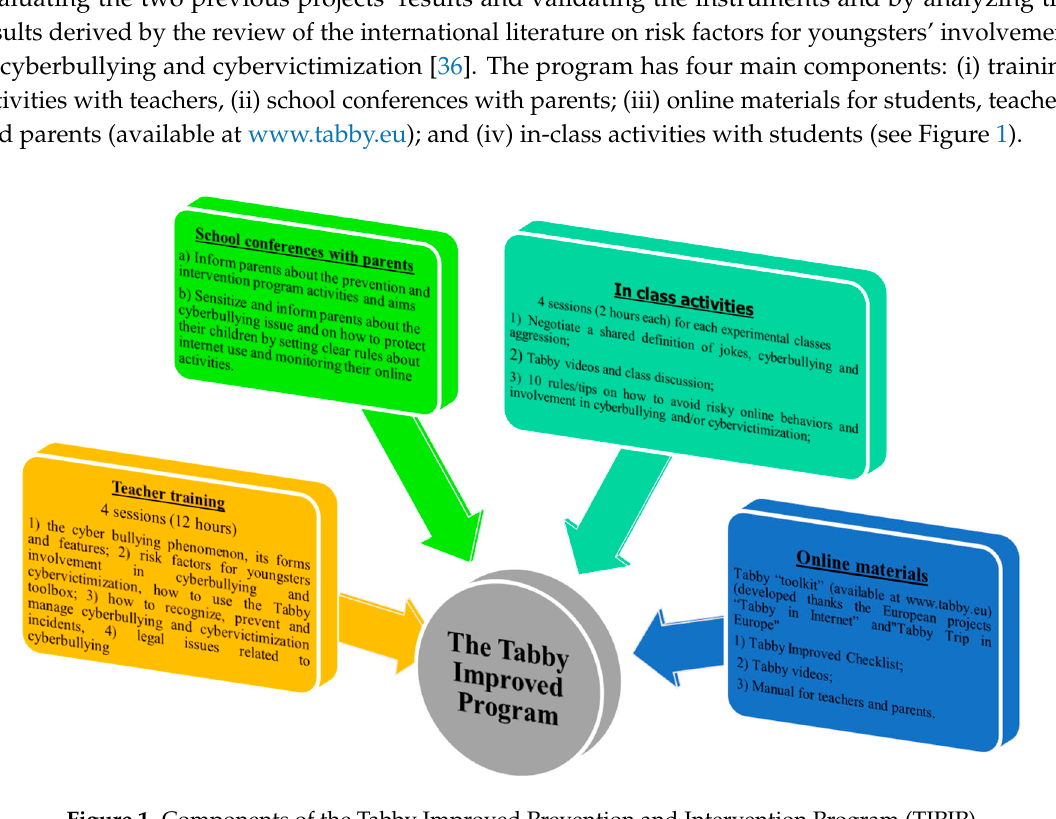
Figure 1. Components of the Tabby Improved Prevention and Intervention Program (TIPIP).